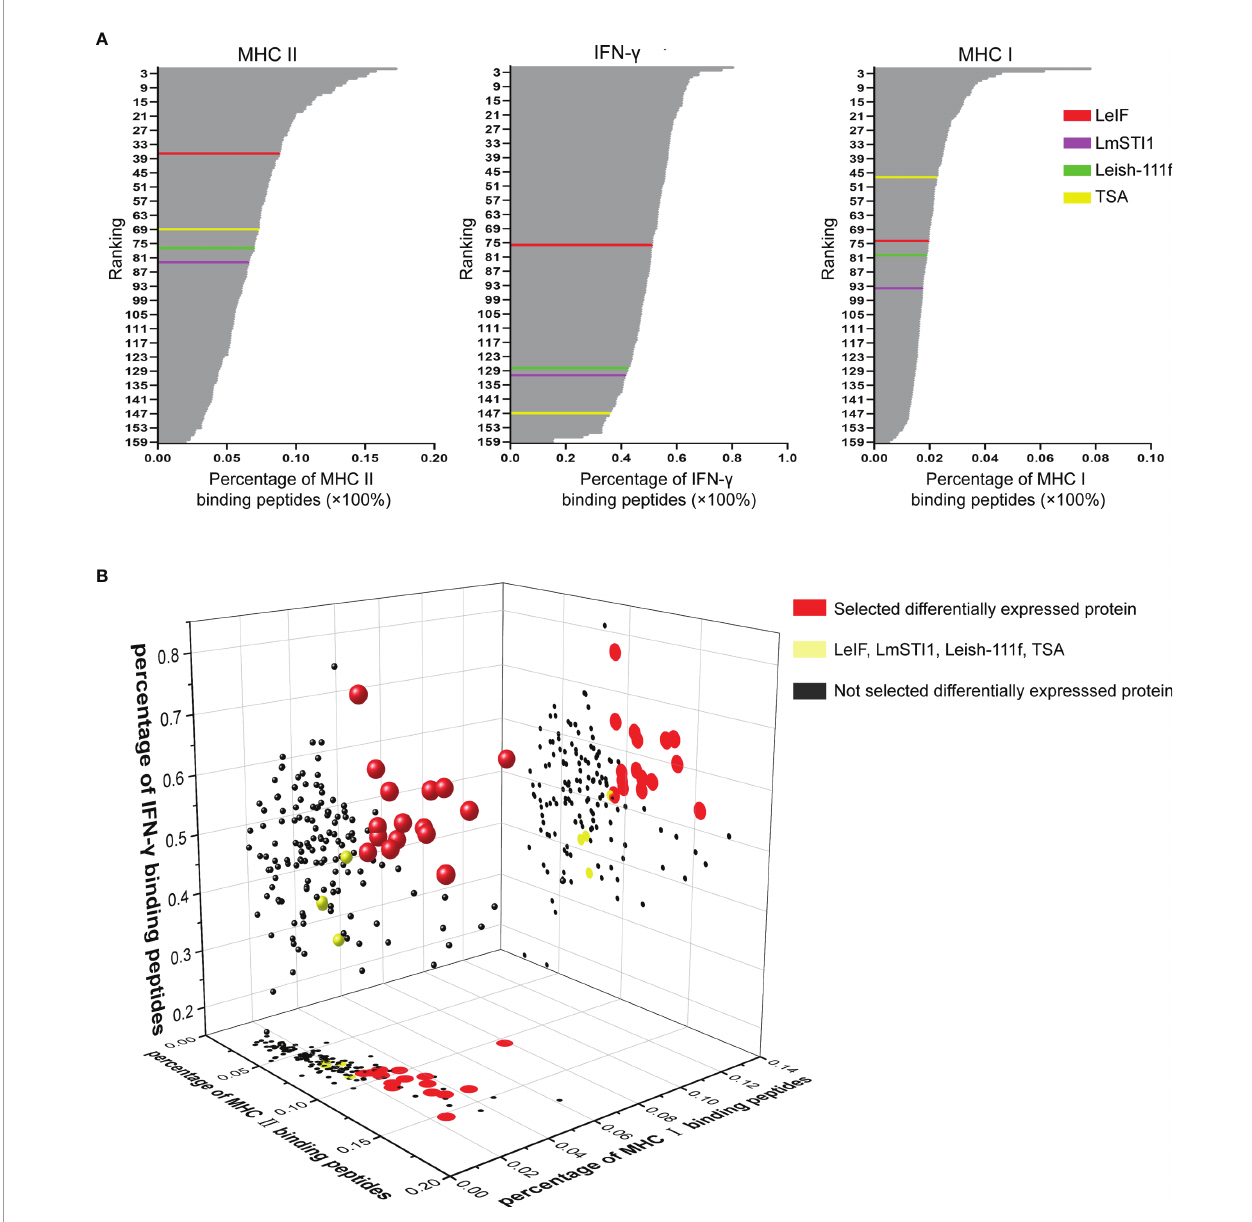
FIGURE 3 | MHC II, IFN- g , and MHC I epitope prediction. (A) According to the percentage of MHC II, IFN- g , and MHC I binding peptides, 155 differentially expressed proteins and control groups (LeIF in red color, LmSTI1 in purple, Leish-111f in green color, and TSA in yellow color) were ranked respectively. (B) The percentages of MHC II, IFN- g , and MHC I binding peptides were analyzed together to rank the 155 differentially expressed proteins and the results were represented as 3D scatter diagram. The 155 spheres were representative of 155 differentially expressed proteins. The 16 red spheres stranded for 16 differentially expressed proteins of which percentages of MHC II, IFN- g , and MHC I epitopes prediction were all greater than those in the control groups (yellow sphere). The differentially expressed proteins which failed to be equipped with all the percentages greater than those of the control groups were marked as black. The plots on planes (MHC II-MHC I and MHC II-IFN- g binding peptide percentage axis) were the projection of